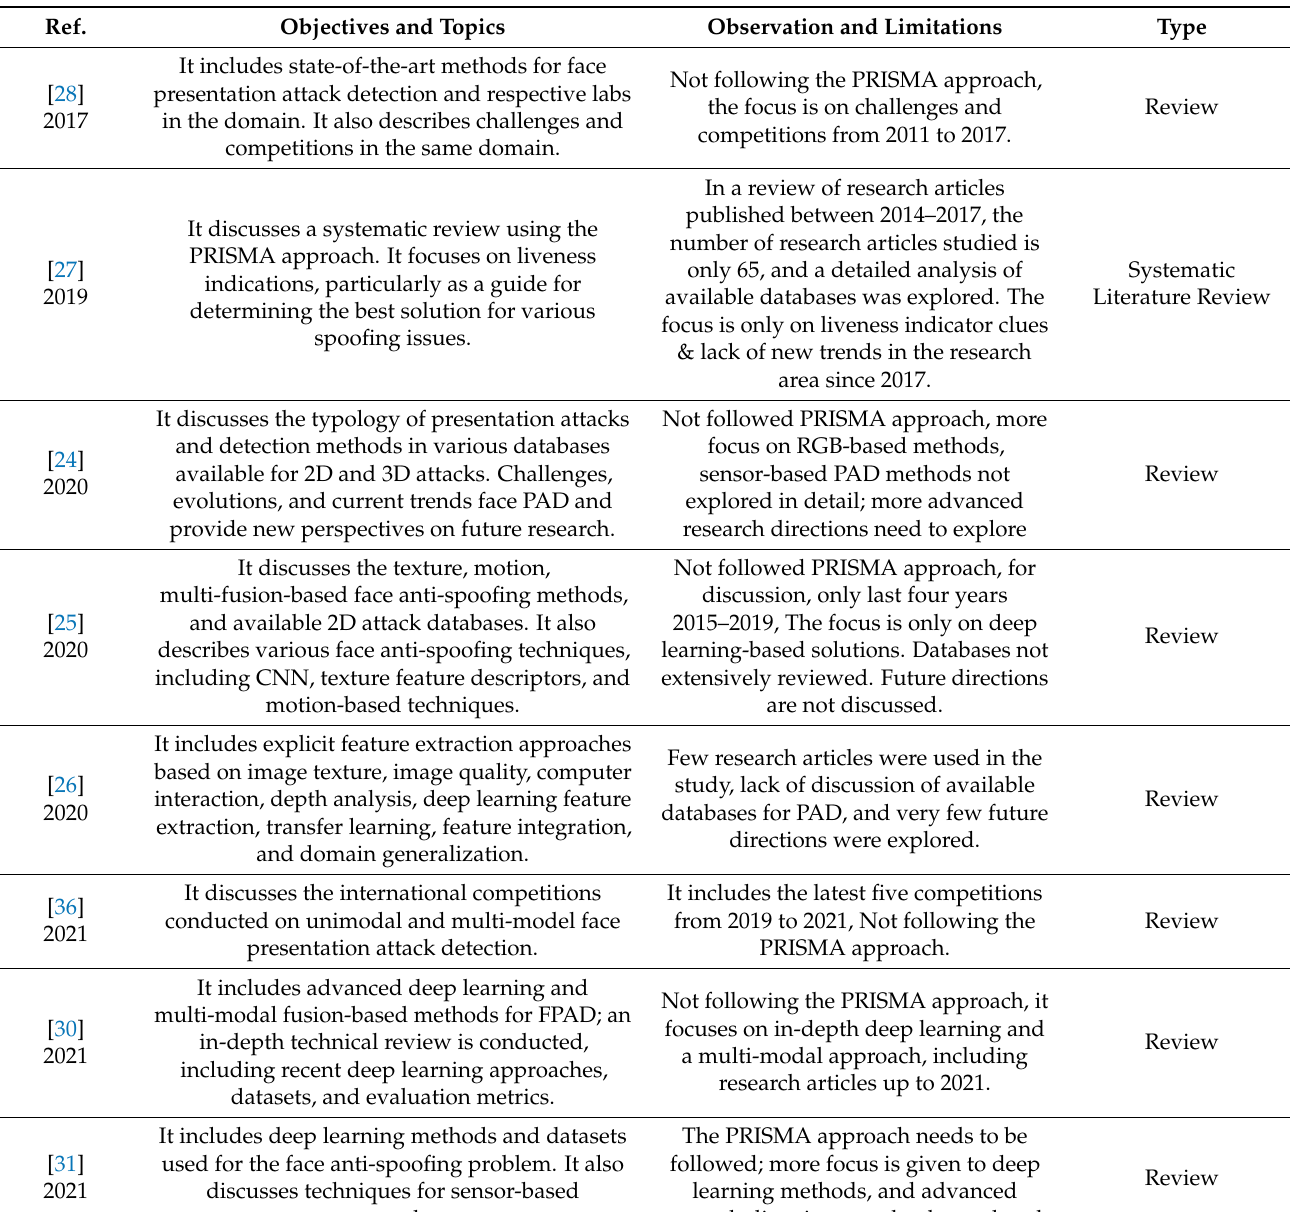
Table 2. Prior research related to